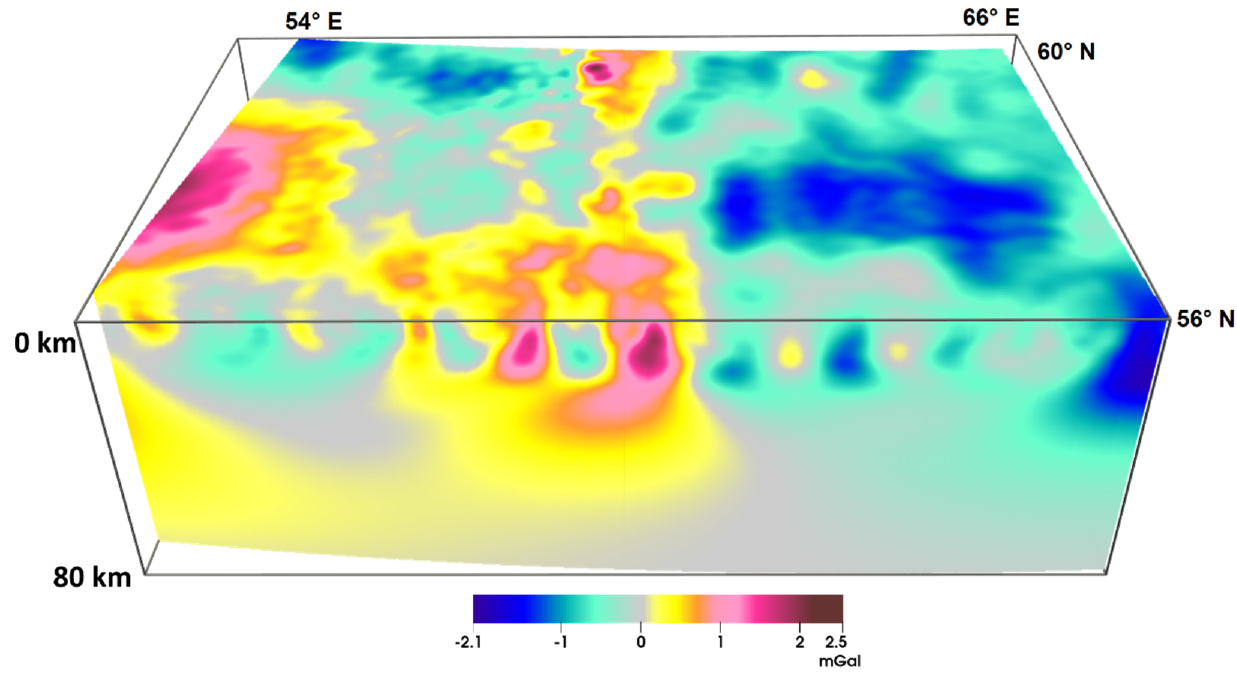
Figure 9. “Cuboid of the separated fields”. The Layers are 1 km thick.